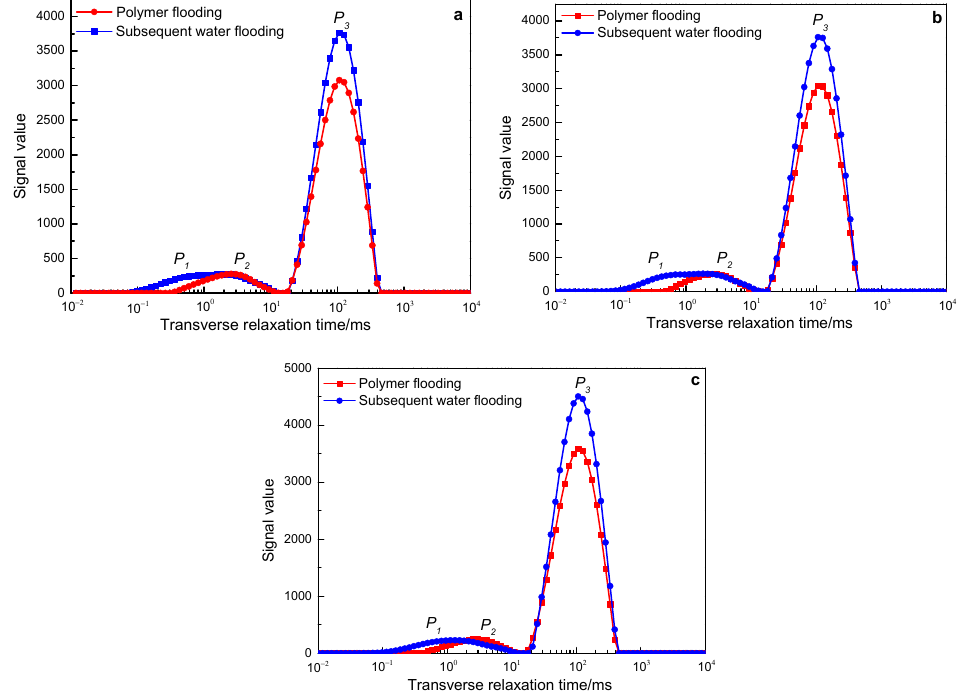
Figure 11. The change characteristics of the NMR T 2 spectrum curves of the polymer solution with a molecular weight of 25 million in rocks with different permeability after polymer flooding and subsequent water flooding: ( a ) 500 mD core; ( b ) 1000 mD core; ( c ) 2000 mD core.